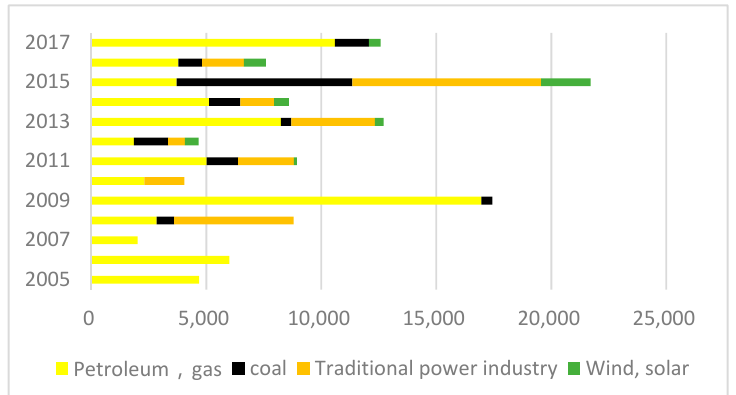
Figure 2. Investment structure in the BRI countries. Data source: China Global Investment Tracker.